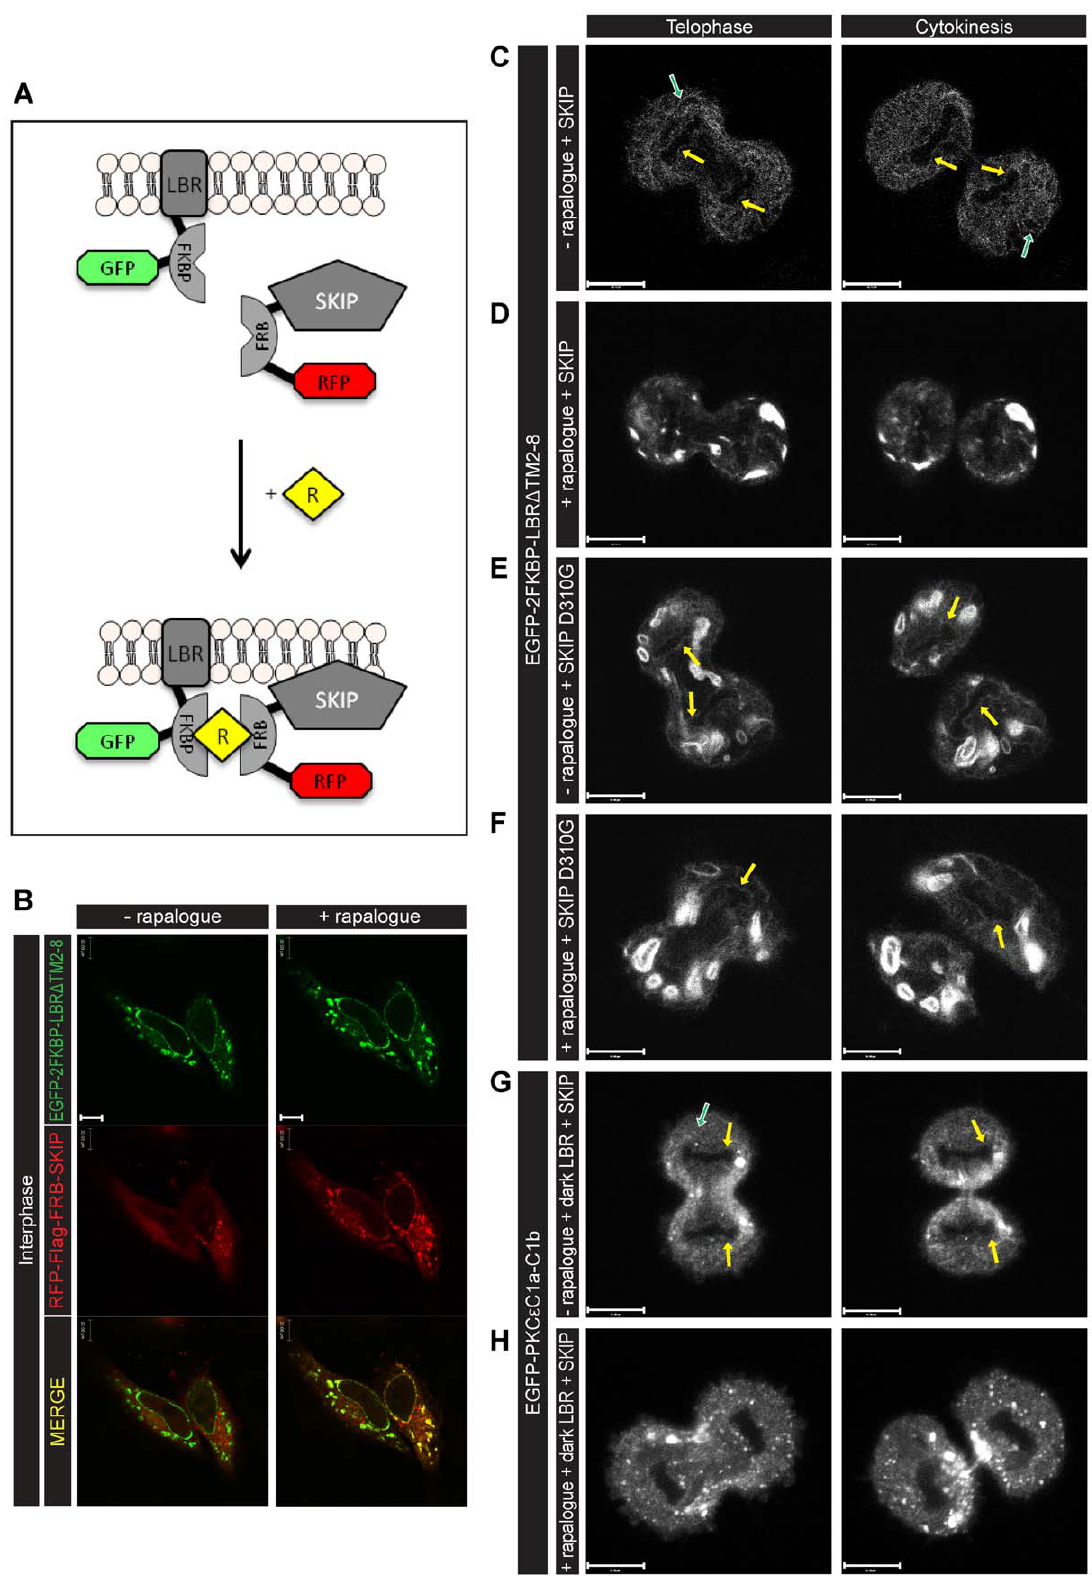
Figure 3. Acute depletion of PtdIns(4,5)P 2 results in an incomplete NE: DAG is not observed upon malformation of the NE. (A) Diagram of the rapalogue dimerisation device. After rapalogue (R) treatment, RFP-Flag-FRB-SKIP (SKIP) dimerises with EGFP-2FKBP-LBR D TM2-8 (LBR) and is recruited to LBR in the ER and NE. (B) Confocal images of live interphase HeLa cells transfected with LBR (green) and SKIP (red) show the